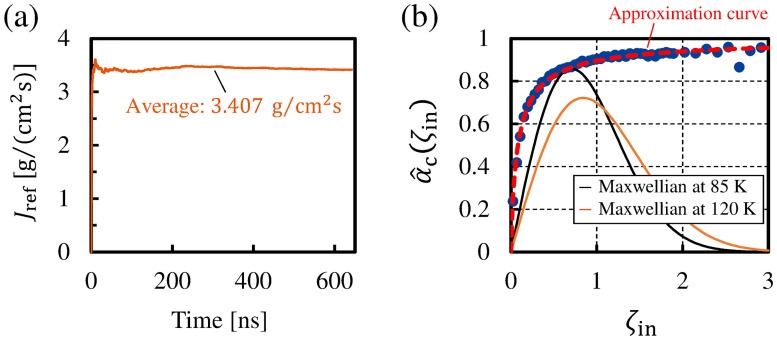
(a) Time evolution of Jref in the present MD study; (b) condensation coefficient for each range of incident velocity ζin.